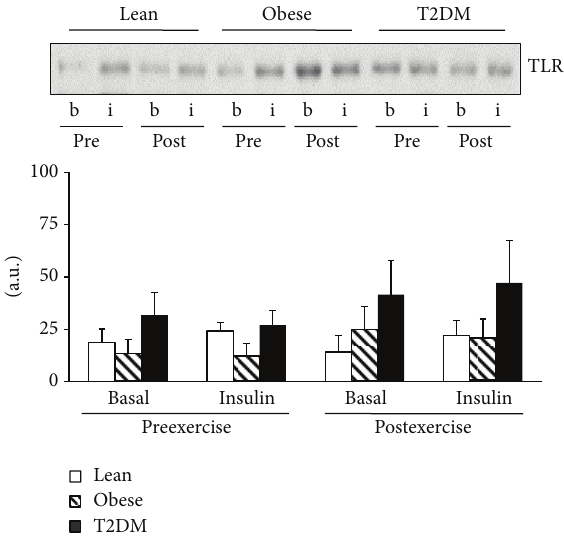
Figure1:TLR4proteincontent.TLR4wasmeasuredinPMNCfrom 17 lean, 8 obese, and 11 T2DM individuals at the basal state (b) and at the end of the insulin clamp (i) before (pre) and after (post) exercise training. Data are means ± SE. Blots are shown for one lean, one obese, and one T2DM individual. ∗ 𝑃 < 0.05 versus lean at basal preexercise training. a.u.: arbitrary units.